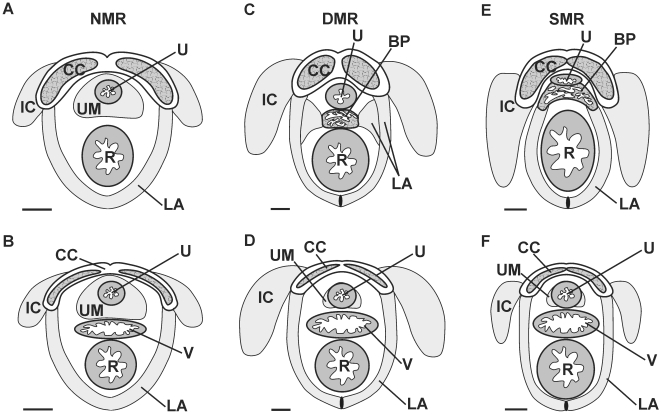
Schematic depictions of sections through the perineal muscles in males and females of three African mole-rat species.Dorsal is down. (A, C, E) Male naked mole-rat, Damaraland mole-rat, and silvery mole-rat, respectively. (B, D, F) Female naked mole-rat, Damaraland mole-rat, and silvery mole-rat, respectively. See text for details. Abbreviations: BP, bulb of penis; CC, corpora cavernosa; IC, ischiocavernosus; LA, levator ani; R, rectum; U, urethra; UM, urethral muscle; V, vagina. Scale bars = 1 mm.